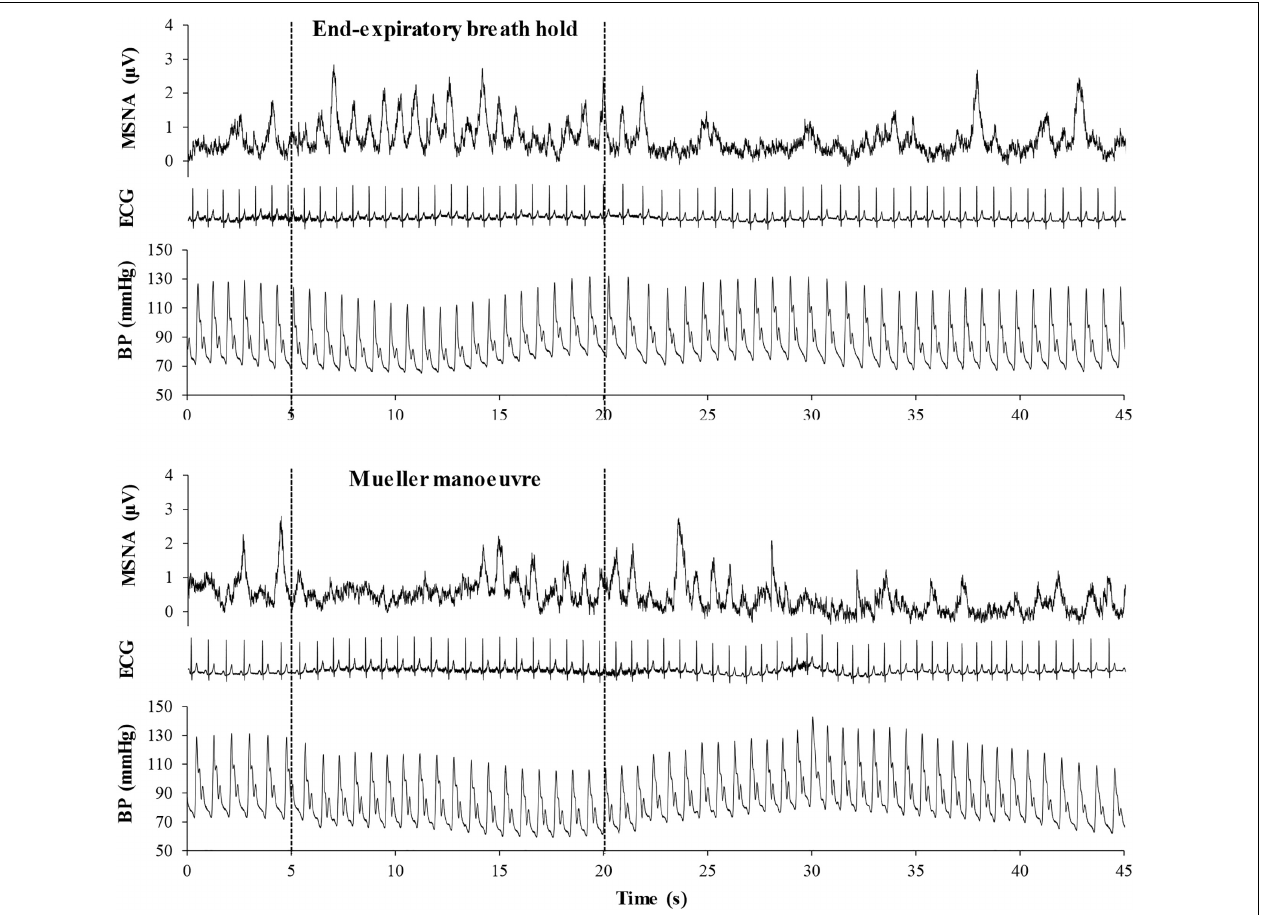
FIGURE 2 | Mean voltage neurogram of muscle sympathetic nerve activity (MSNA), arterial blood pressure (BP), and the electrocardiogram (ECG), illustrating heart rate in a representative study participant before, during, and after a 15-s end expiratory breath-hold ( upper panel ) and a Mueller maneuver ( lower panel ). Note that the time delay between the initiation of the breathing task and the onset of sympathetic excitation was longer for the Mueller maneuver than for the breath-hold, due to initial aortic baroreceptor stimulation by the increase in intra-thoracic transmural pressure. However, the sympatho-excitatory responses to the two breathing tasks were of similar